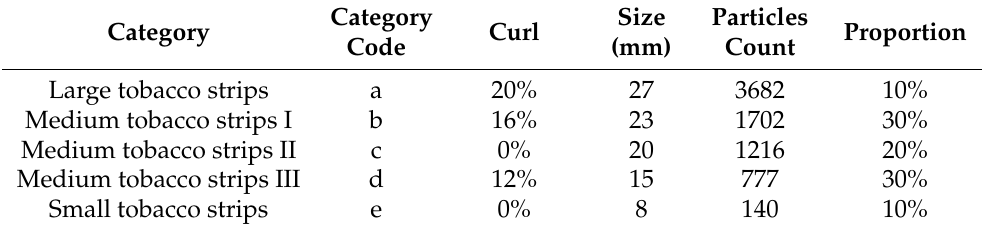
Table 2. Curl degree, size, and proportion of five tobacco strips models.